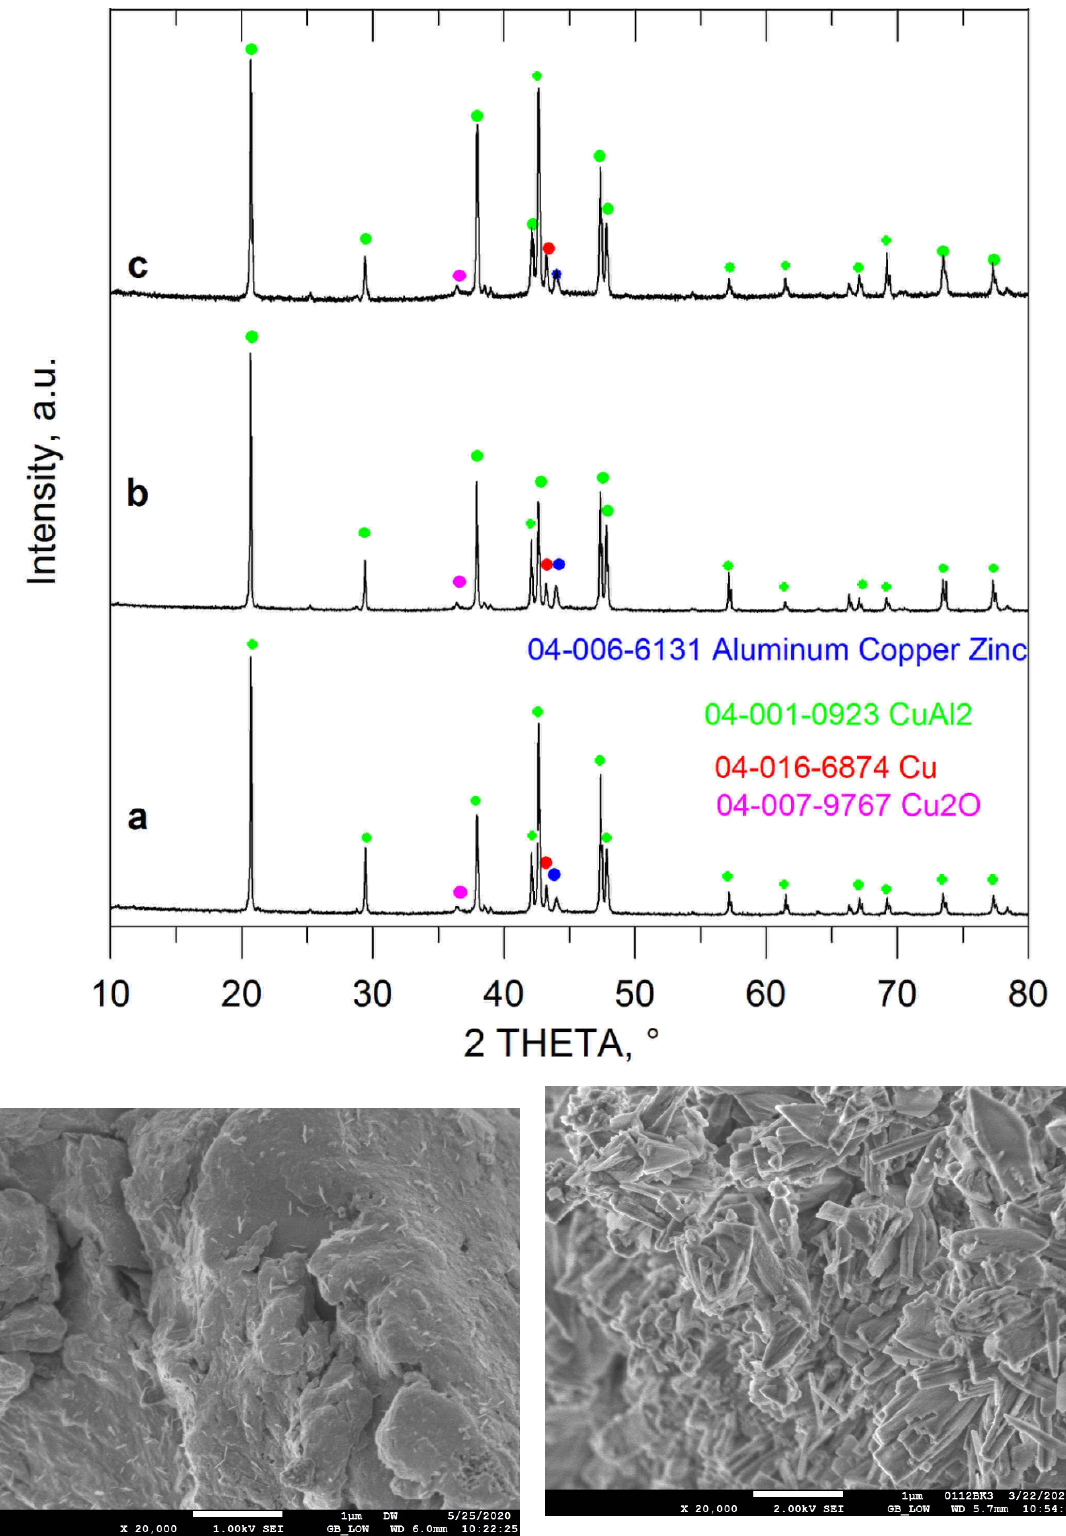
Figure 5. Powder X-ray diffractograms ( top ) of undissolved residue of Dev. alloy (0.7 g) after ( a ) 2 h; ( b ) 4 h and ( c ) 6 h of reaction with 5 mM aq. BRX dissolved in 20 mM NaOH (100 mL) and the coaction of NaBH 4 (0.8 g) and the SEM images of unused Dev. alloy ( bottom left ) and insoluble part of Dev. alloy after 6 h of reaction with 5 mM aq. BRX dissolved in 20 mM NaOH (100 mL) with coaction of NaBH 4 (0.8 g) ( bottom right ).